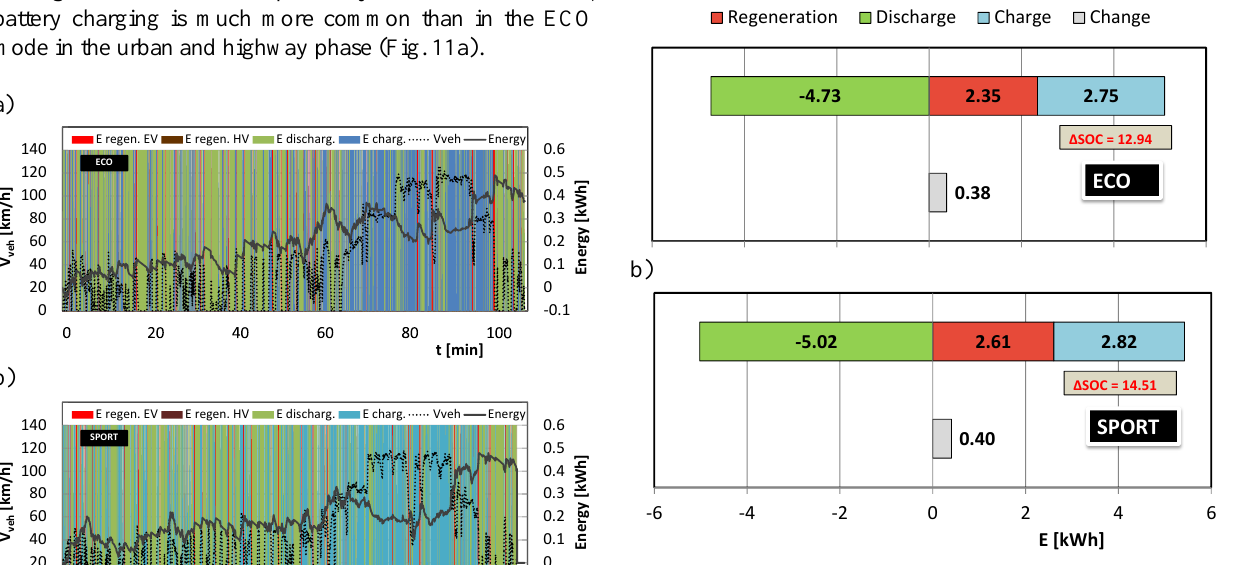
Fig. 12 Total energy flow recorded in a hybrid drive system in the two driving modes: a) ECO, b)